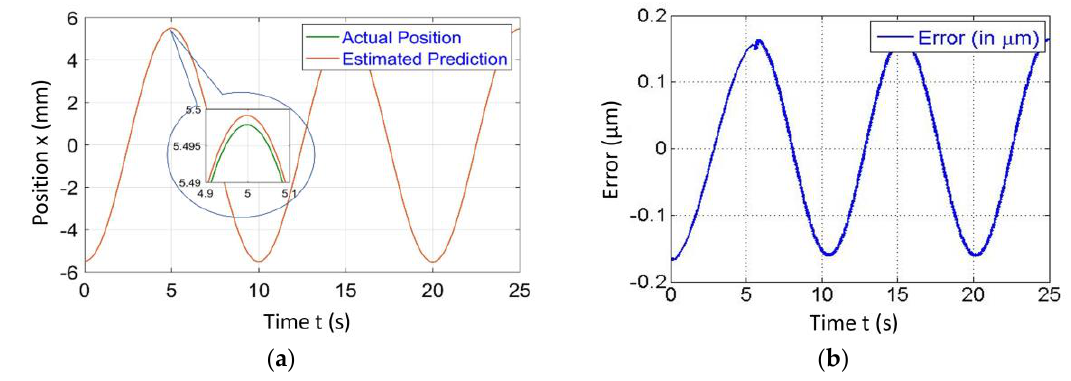
Figure 4. Simulated results of the position estimator algorithm at 0.1 Hz frequency for ( a ) Position comparison and ( b ) Error between actual and estimated position.